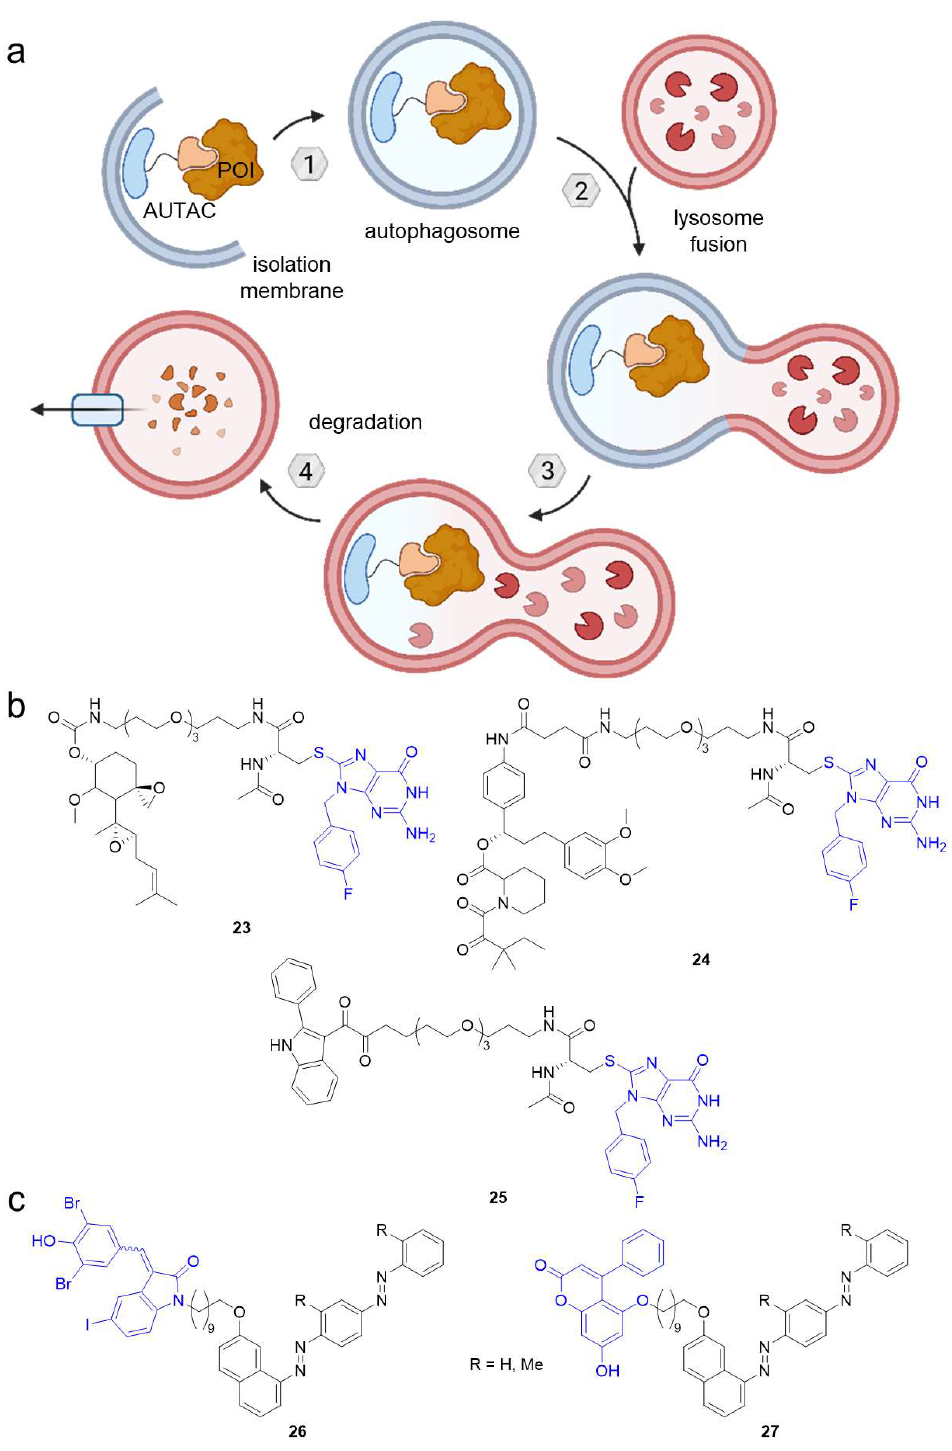
Figure 14. Autophagy-targeting chimeras (AUTACs) feature an S -guaninyl tag to target the POI for autophagosomal degradation involving K63-linked polyubiquitination. ( a ) AUTACs bind a POI and are recognized by autophagy receptors. The POI is wrapped by the autophagosome, which fuses with a lysosome. Eventually, the POI is degraded by proteolysis. ( b ) AUTACs targeting MetAP2 ( 23 ), FKBP12 ( 24 ), and TSPO ( 25 ). ( c ) Autophagy-tethering compounds (ATTECs) can target non-protein biomolecules like lipid droplets for autophagosomal degradation. The blue groups are ligands for autophagosome protein LC3. Using a C 10 alkyl chain, the LC3 ligands GW5074 ( 26 ) and 5,7-dihydroxy-4-phenylcoumarin ( 27 ) were coupled to Oil Red O derivatives binding lipid droplets.